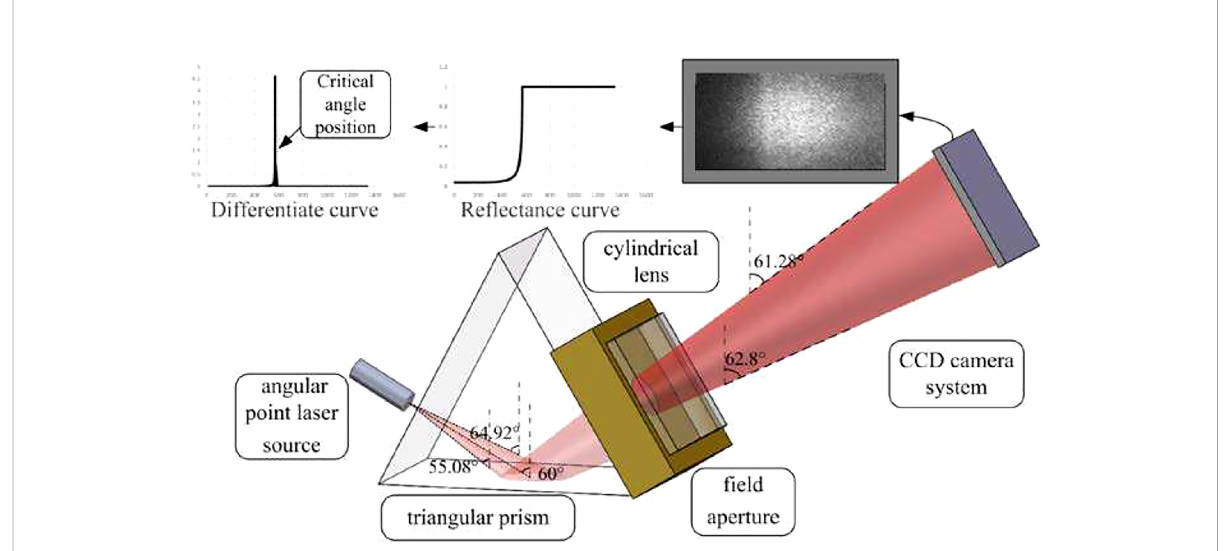
FIGURE 2 Principle of a refractometer based on total re fl ection (from Chen et al.,